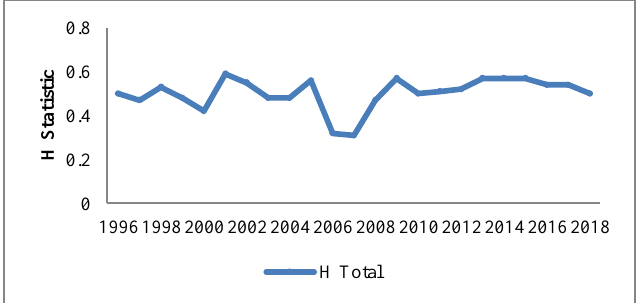
Figure 2: Degree of Bank Competition of Sri Lankan banks 1996-2018; Source: Calculations by the author